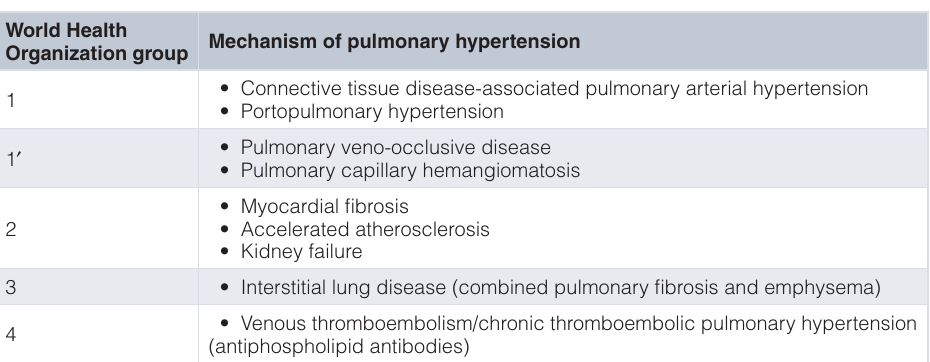
Table 1. Mechanisms of pulmonary hypertension in systemic